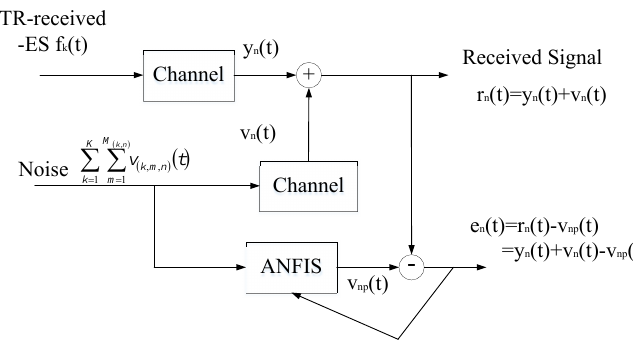
Figure 5. Schematic diagram for noise suppression using